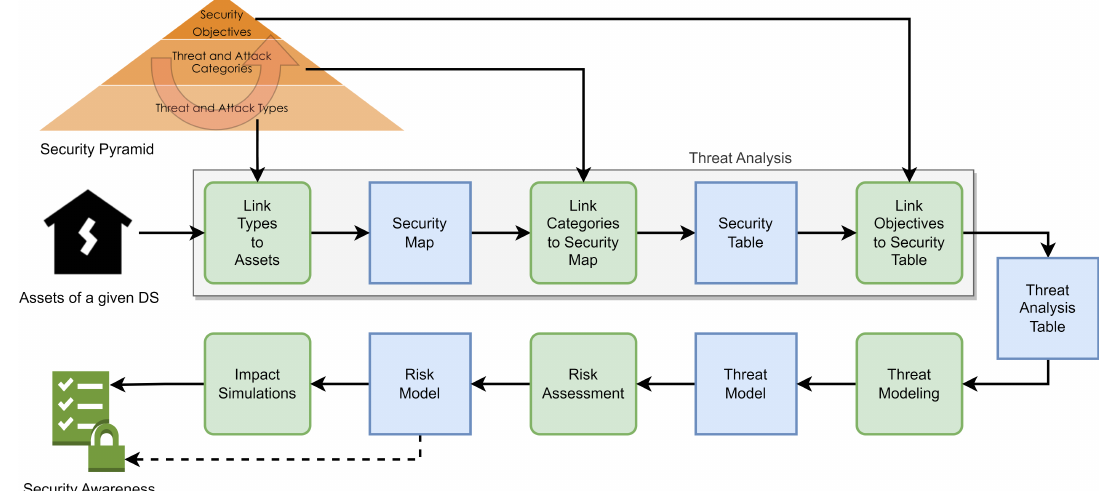
Figure 4. Digital Substation Cyber Security Analysis Approach